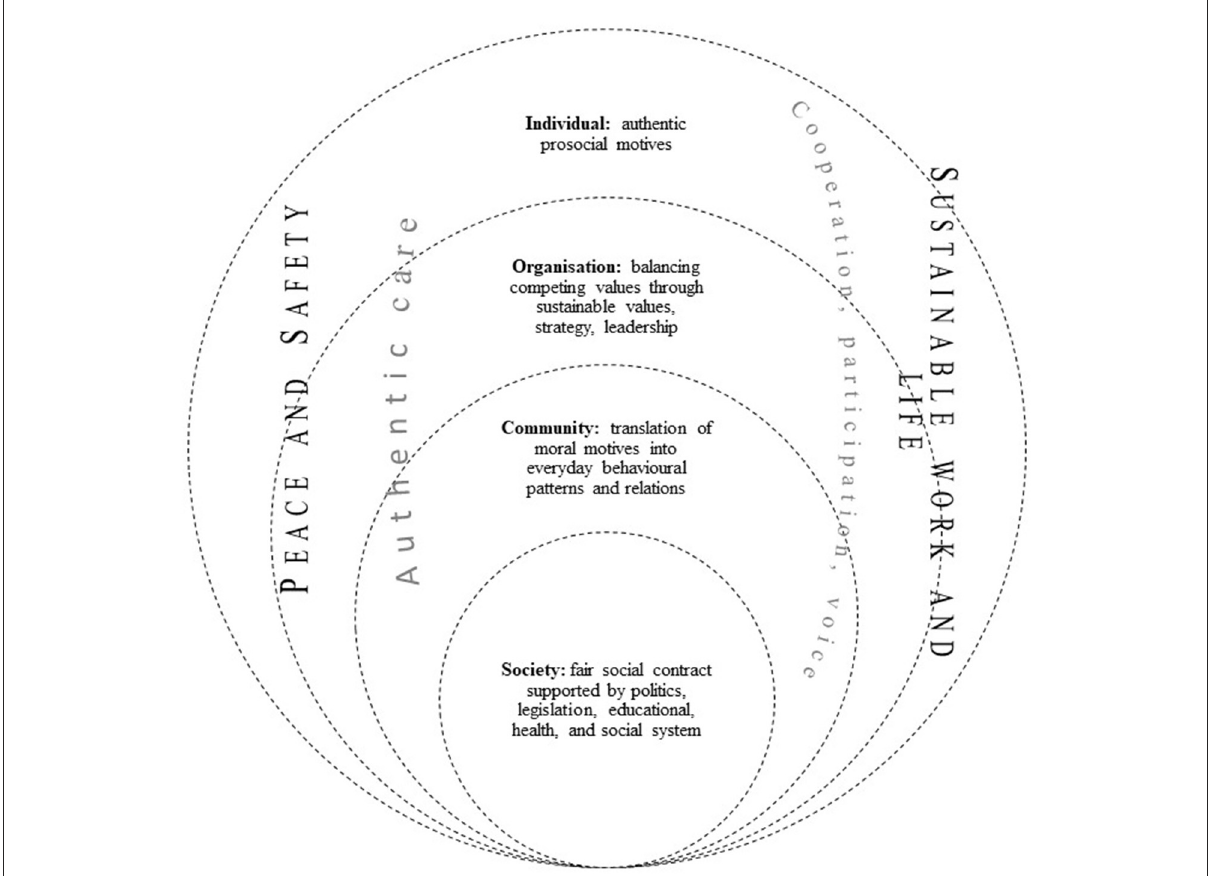
FIGURE4 Theoretical model—psychological concept of social sustainability in the workplace from the perspective of sustainable